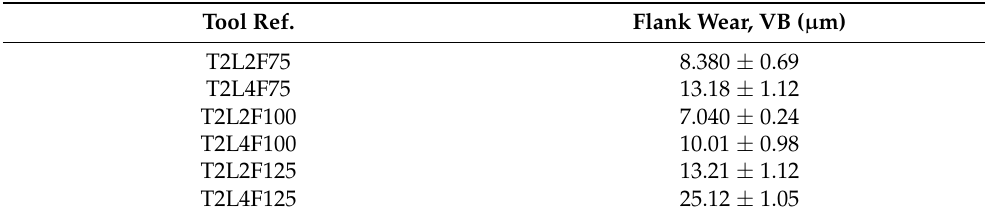
Table 13. VB values obtained from measurements performed on the clearance faces of T2 tools. Tool